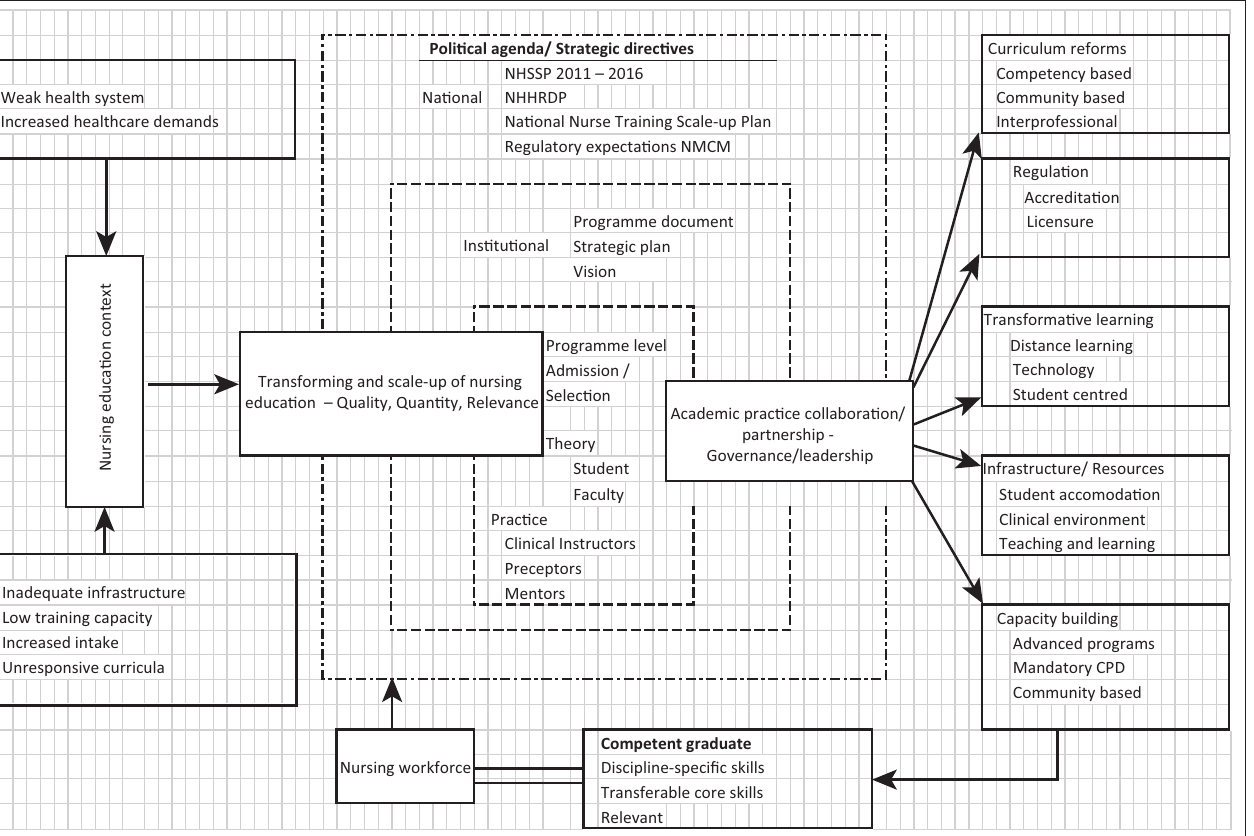
FIGURE 1: A middle-range model of improving quality, quantity and relevance of nursing education in